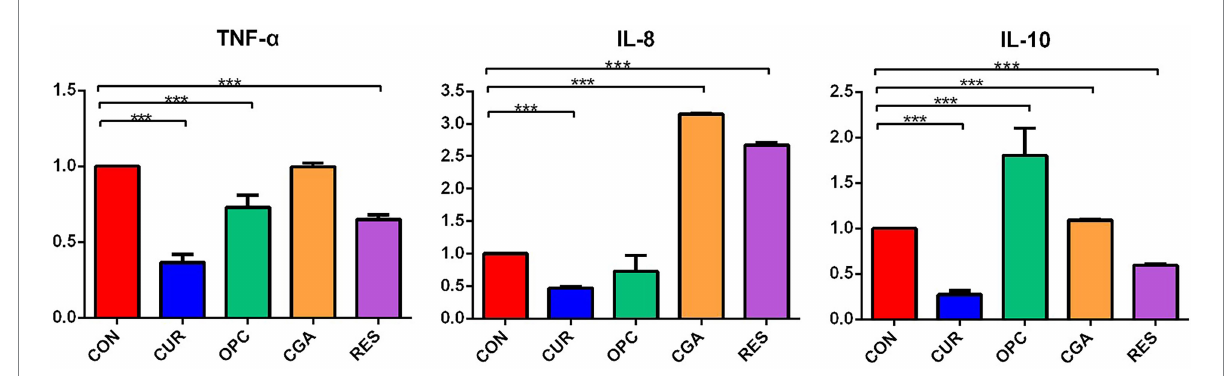
FIGURE 2 Relative expression of tnf- α , il-8 and il-10 genes in response to dietary plant polyphenols ( n = 9 per treatment). Data are presented as mean ± standard deviation. Significant differences were labeled as *** for p < 0.001. CON, control group; CUR, curcumin group; OPC, oligomeric proantho cyanidins group; CGA, chlorogenic acid group; RES, resveratrol group.